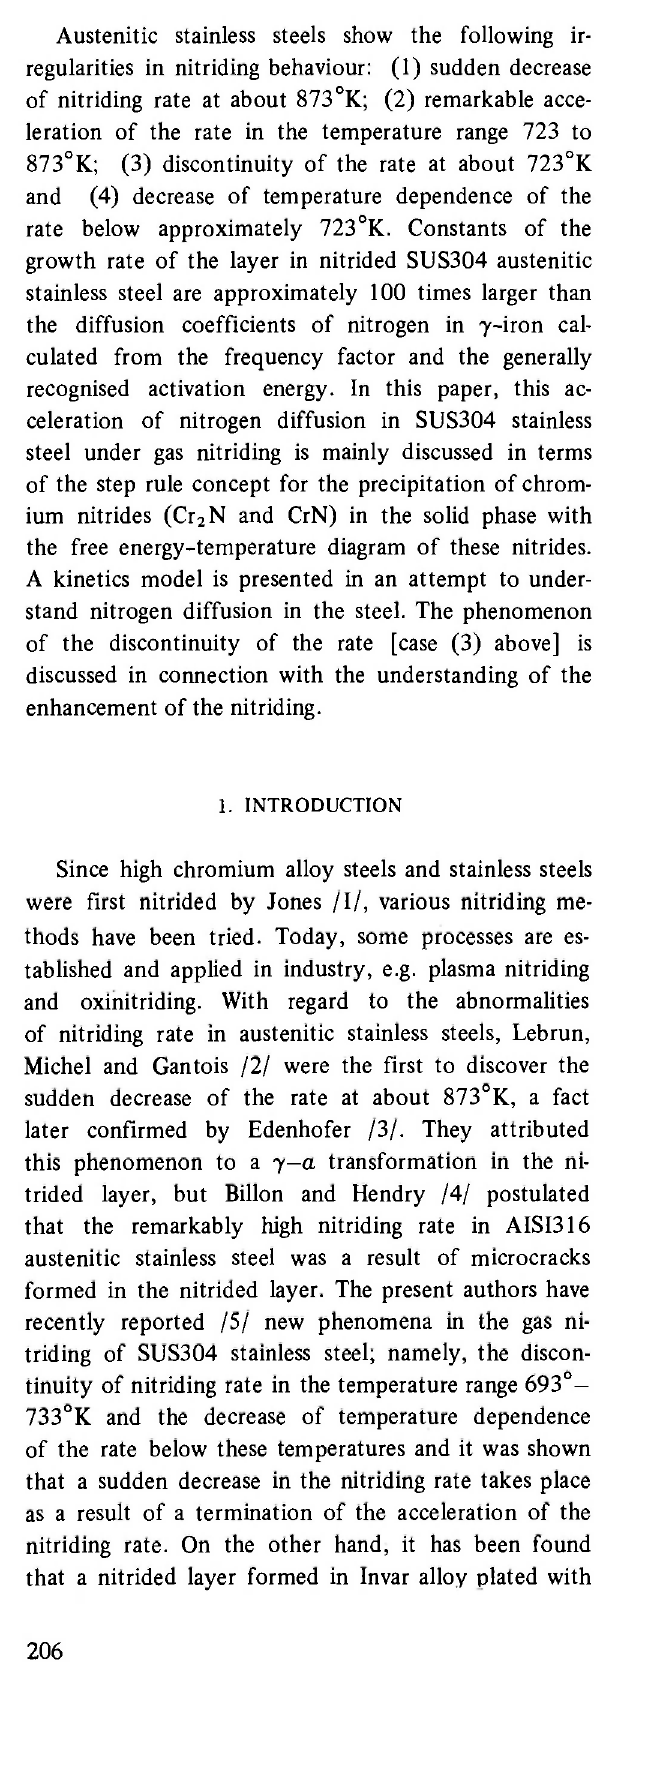
Fig. 1. Thickness of nitrided layer vs temperature for SUS304 stainless steel nitrided in ammonia gas in the tem- perature range 673°-923°K for 25.2 ks. A dotted curve shows a penetration depth of nitrogen in γ-iron calculated from the frequency factor (D 0 = 0.91 cm